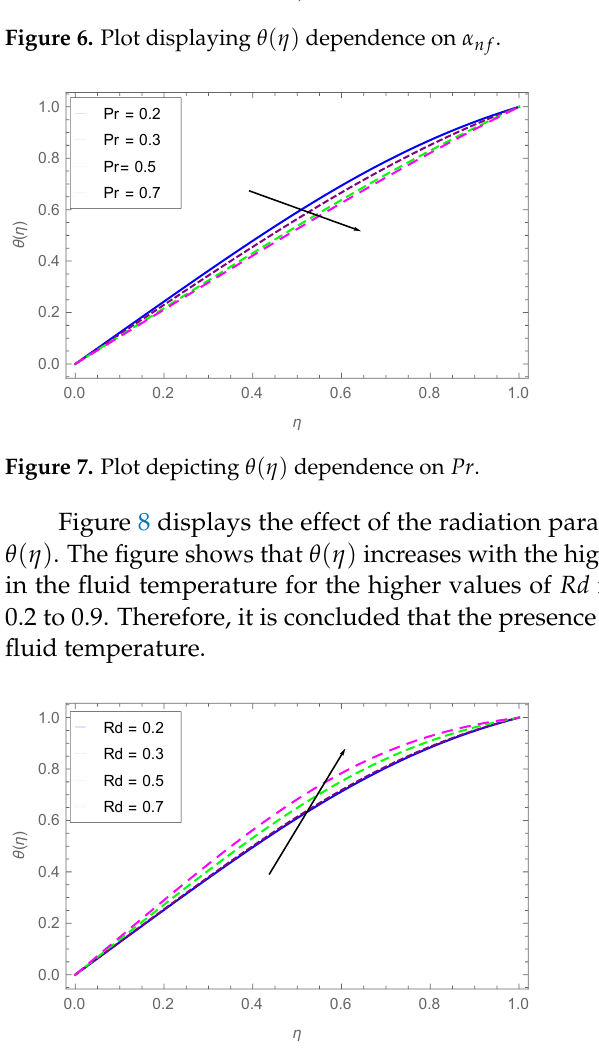
Figure 8. Plot showing θ ( η ) dependence on Rd